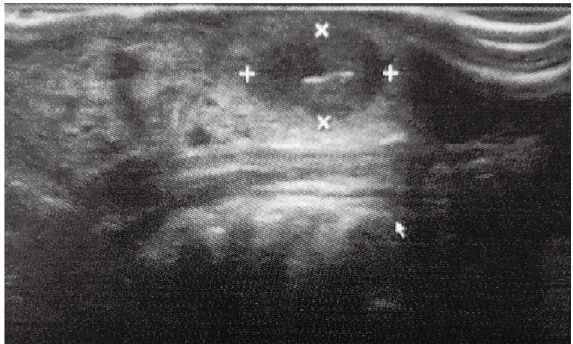
Figure 2: Ultrasonography showing a circumscribed nodular lesion. The echographic aspect was suggestive of a foreign body inside, suggesting an image compatible with a thorn, with granuloma formation.